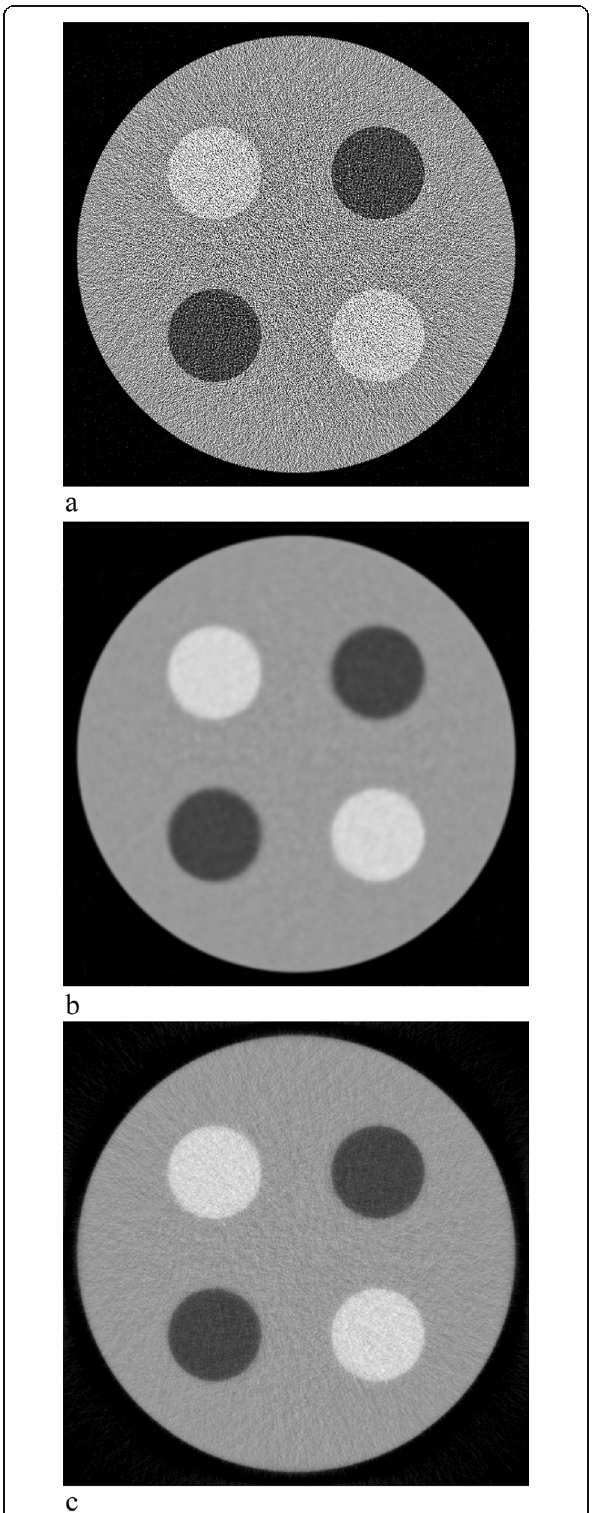
Fig. 11 Larger image display for lower noise transmission data reconstructions. a : View of the upper-right image in Fig. 5 (EM-lookalike algorithm); b : View of the upper-right image in Fig. 6 (proposed algorithm); c : View of the upper-right image in Fig. 9 (POCS algorithm in ref.